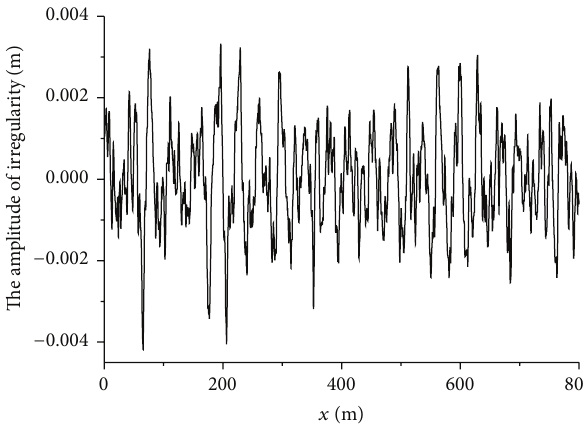
Figure 4: Time domain random irregularity sample of the Ger- manic low-disturbance spectrum.